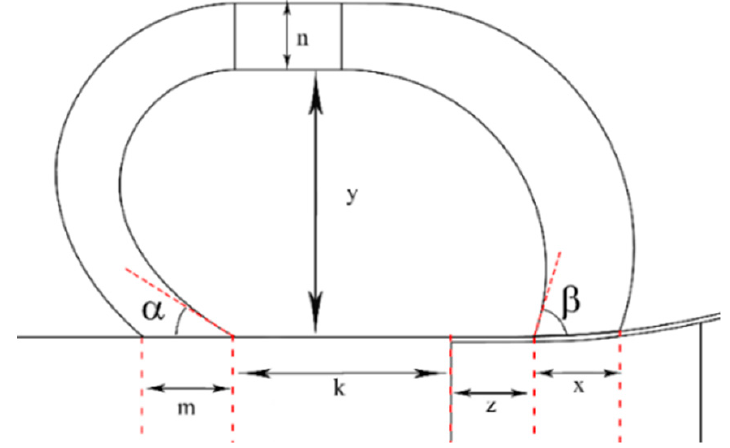
Figure 2. The geometric structure of the self-circulating casing. Table 2. The geometric parameters of the self-circulating casing.